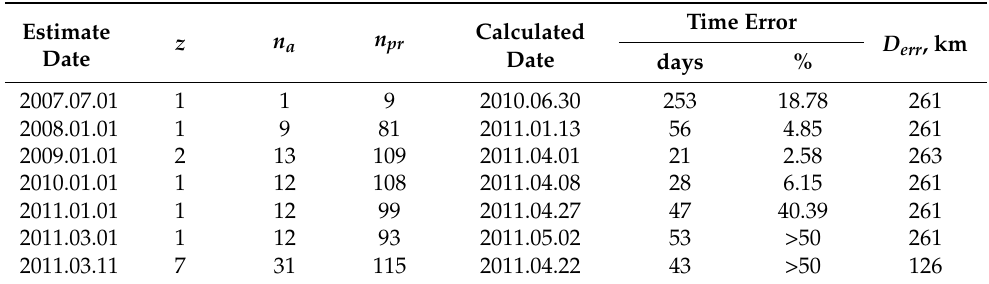
Figure A10. Retro predictability of the earthquake on 11 March 2011 in the zone with the highest (at the estimate date; see Figure A9, column ‘a’) number of successful predictive extrapolations (see Figure A4 for explanations). Table A8. Retro estimation of the place and time of the earthquake on 11 March 2011 by the cluster of its precedent activity.